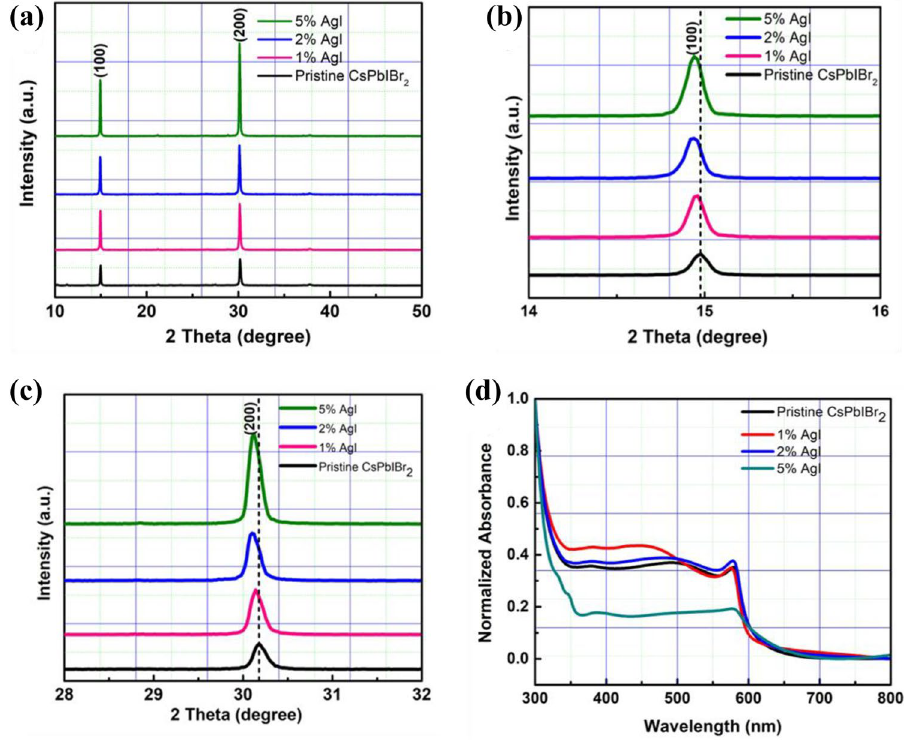
Figure 1. ( a ) XRD pattern of CsPbIBr 2 perovskite films with and without AgI doping. ( b ) (100) peaks shift of the perovskite films. ( c ) (200) peaks shift of the perovskite films. ( d ) UV–vis spectra of with and without AgI